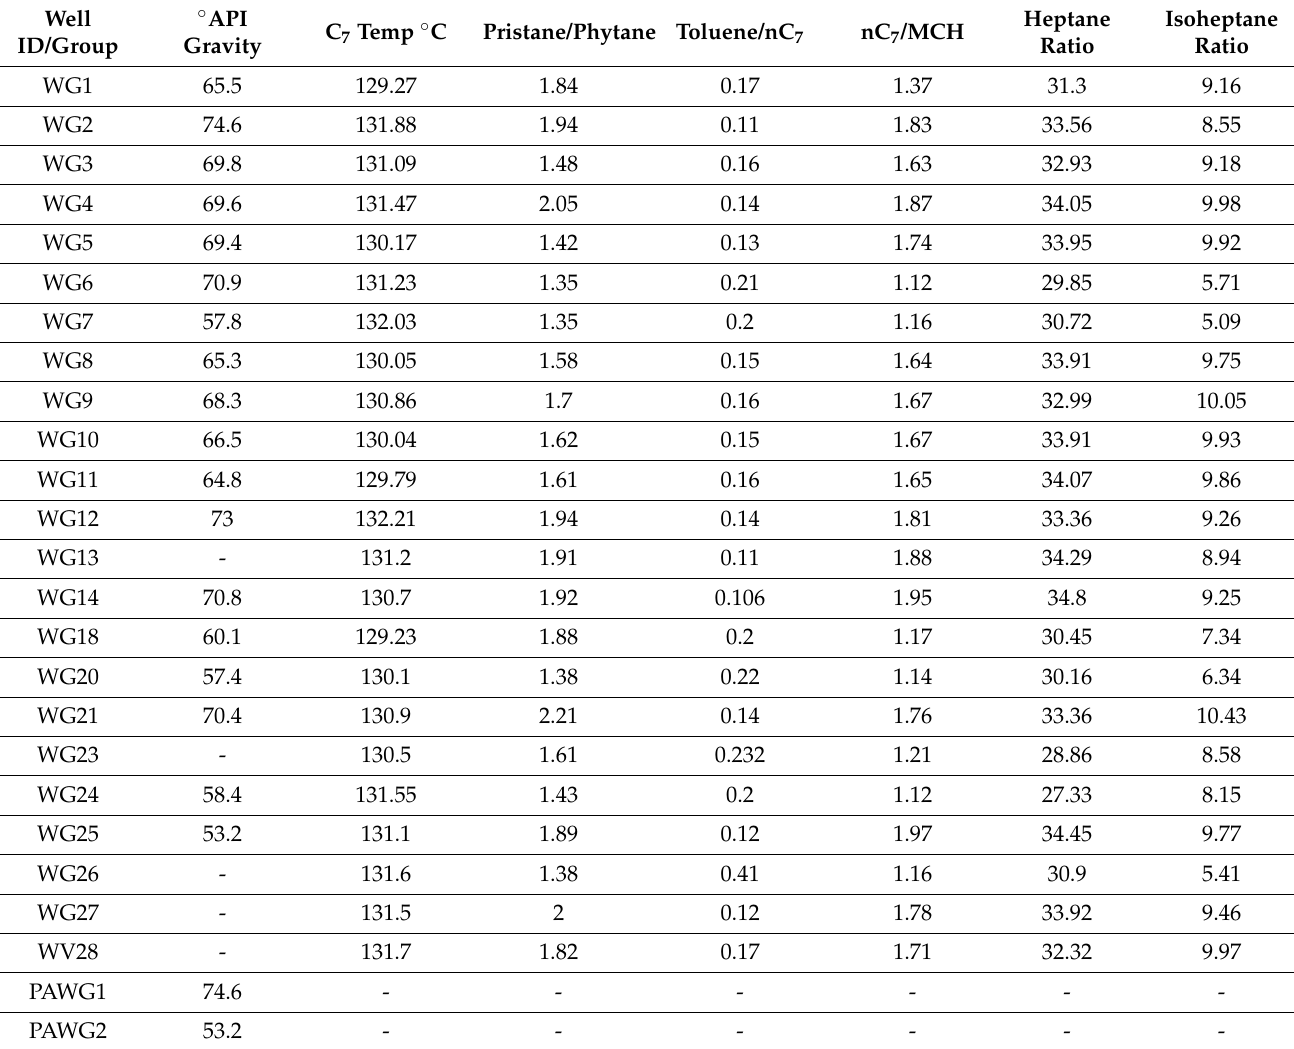
Table 6. Condensate data for selected